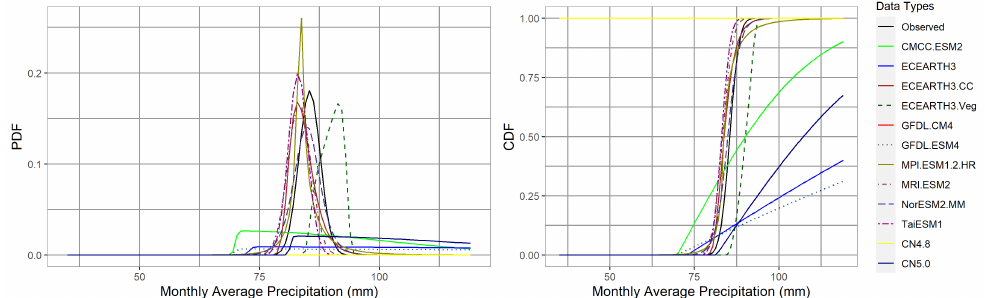
Figure 2. Fitted distribution for the monthly average precipitation (black line) series of the observed and 10 climate models (indicated with different